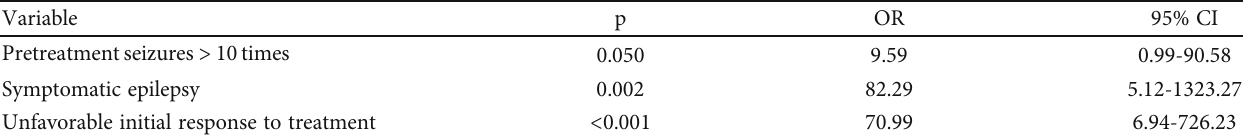
Table 4: Results of logistic regression analysis for risk factors of AED